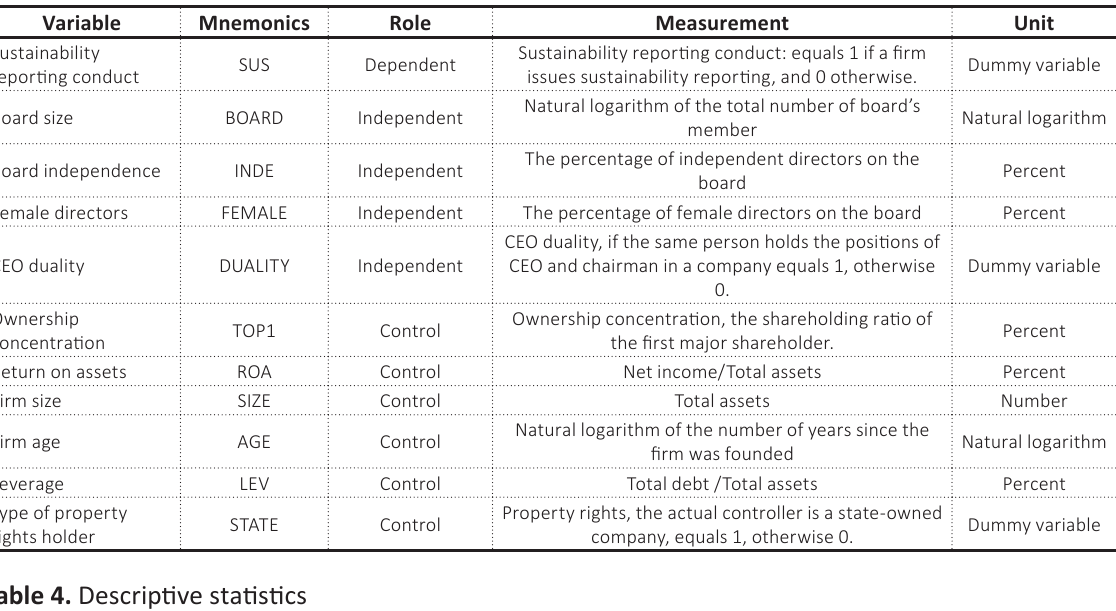
Source: Developed by the authors.